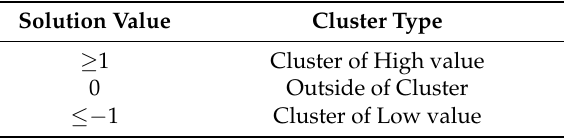
Table 2. Cluster types and associated solution values.